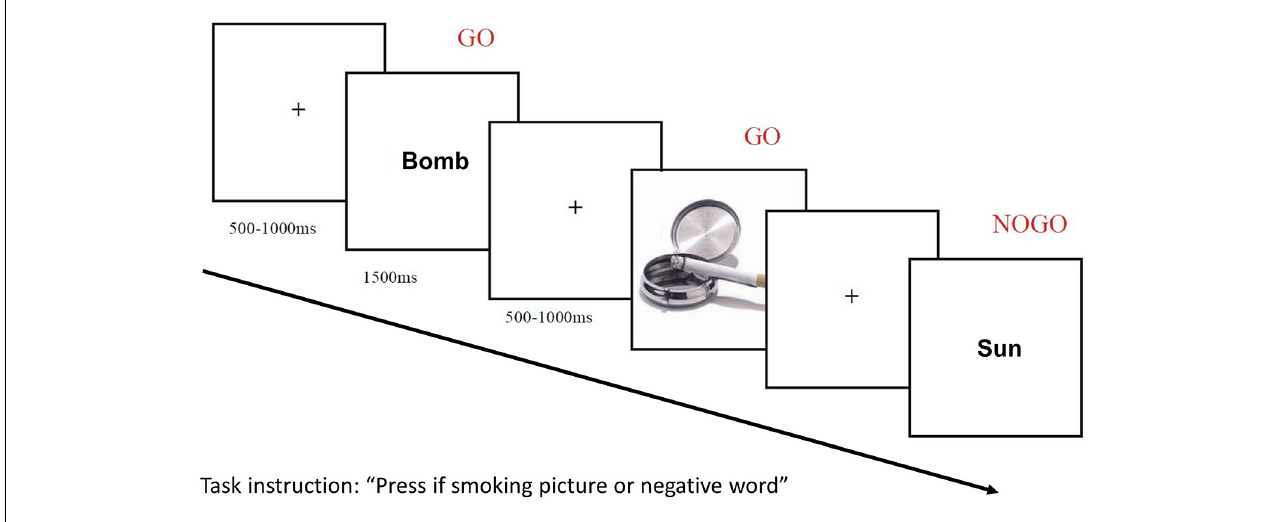
FIGURE 1 | Schematic drawing of the trial procedure of the Go/Nogo association task (GNAT). The participant views a random series of stimuli comprising pictures (smoking-related and neutral) and words (positive and negative) with the task of pressing a button as fast as possible for one picture category (in this example smoking-related) and one word category (in this example negative words), while withholding responses for the other categories.